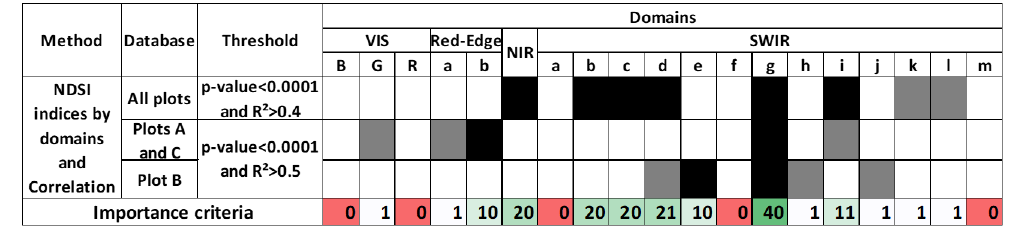
Table 10. Summary of the previous results.